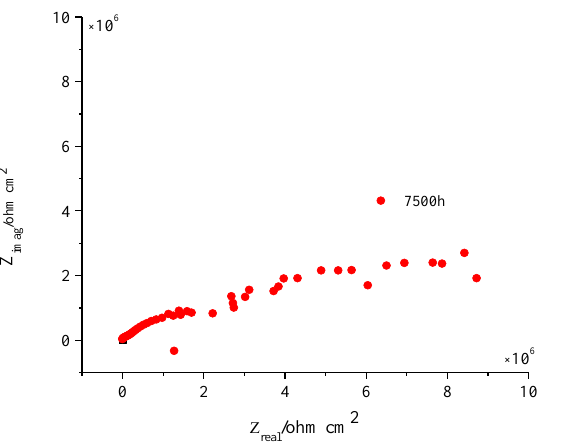
Figure 11. Nyquist chart of inorganic zinc-rich coating after being salt sprayed for 7500 h.